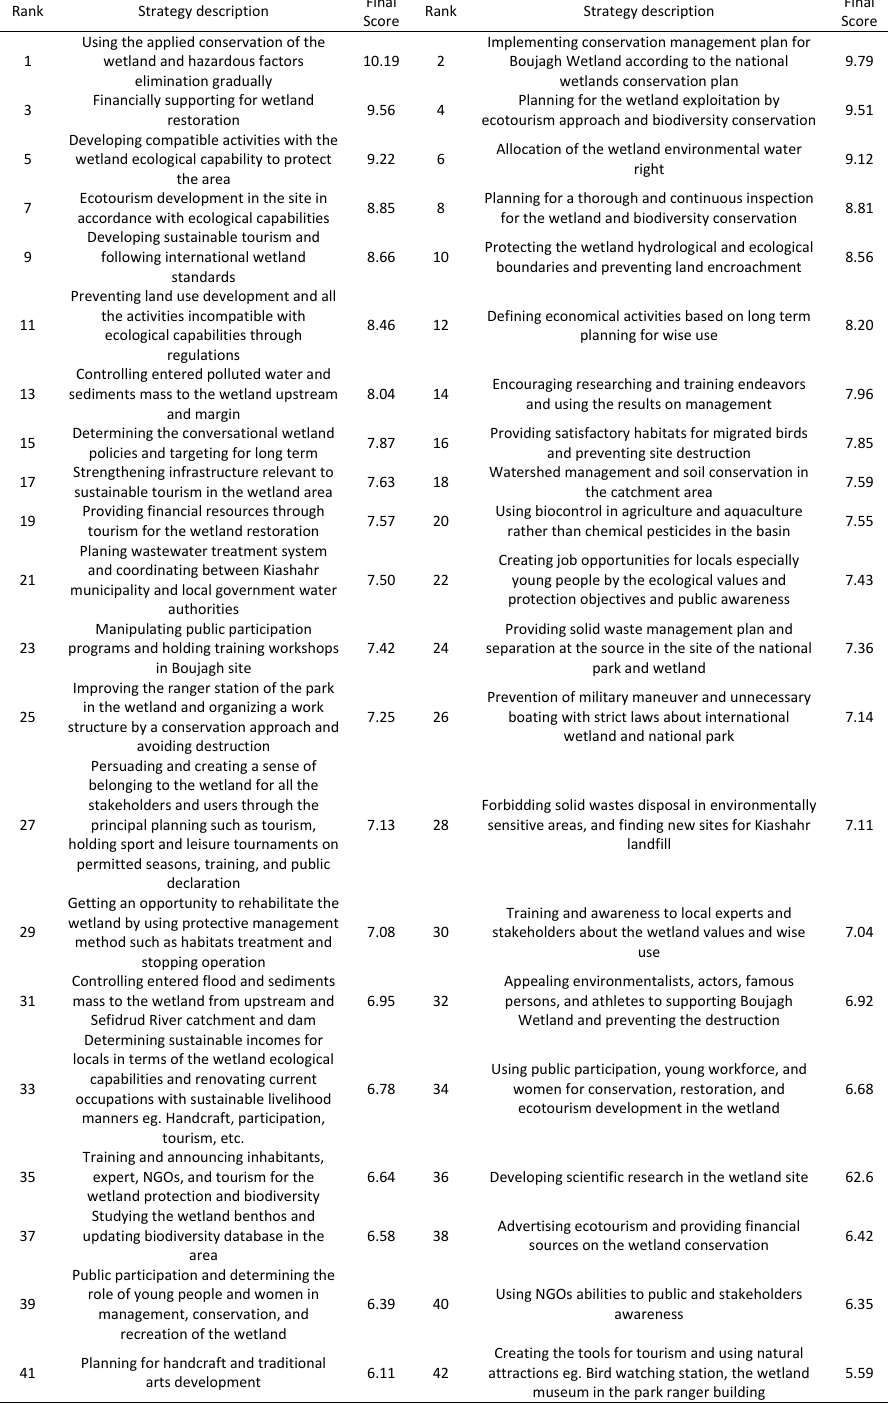
Table 4: Strategies prioritization and quantification on QSPM matrix